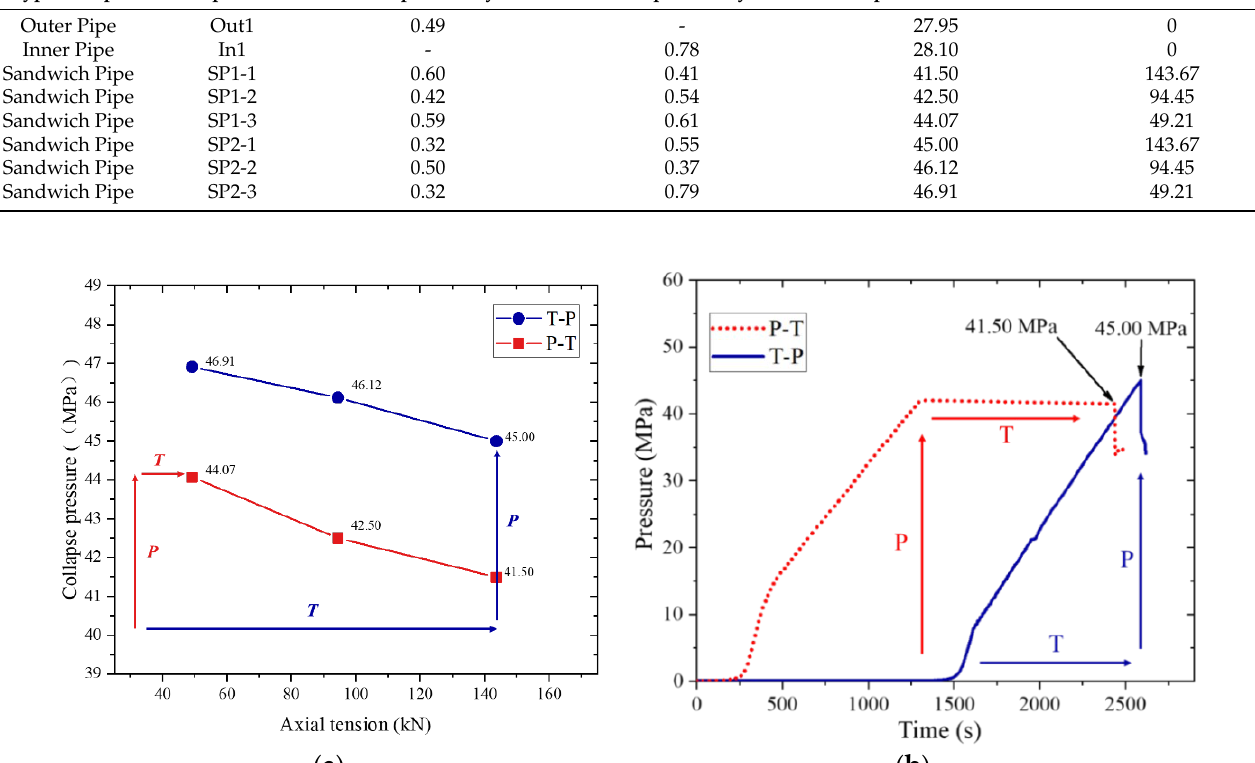
Figure 6. ( a ) Collapse envelopes of different loading paths. ( b ) Pressure–time diagrams of tested specimens SP1-1 and SP2-1.